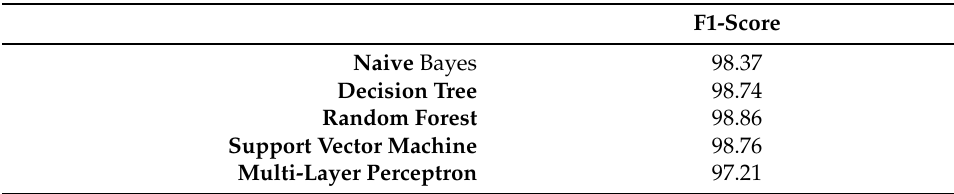
Table 4. F-measure results of models’